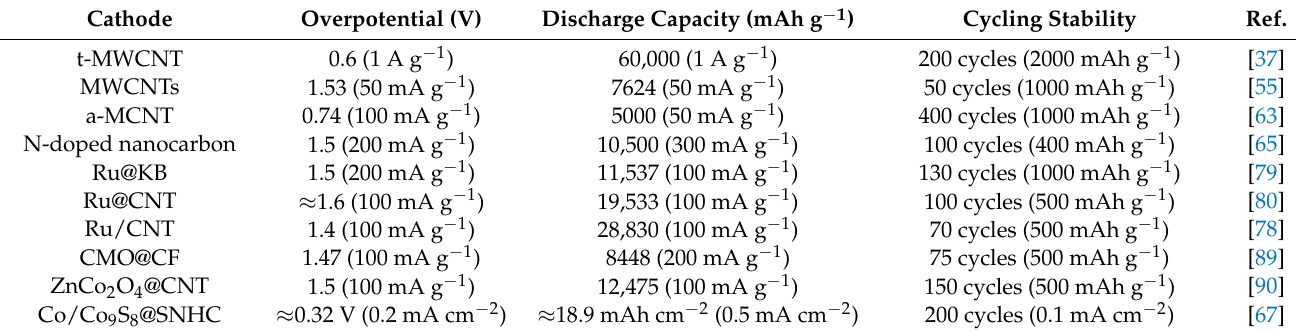
Table 1. Summary of recent progress in catalytic cathodes for Na-CO 2 batteries.